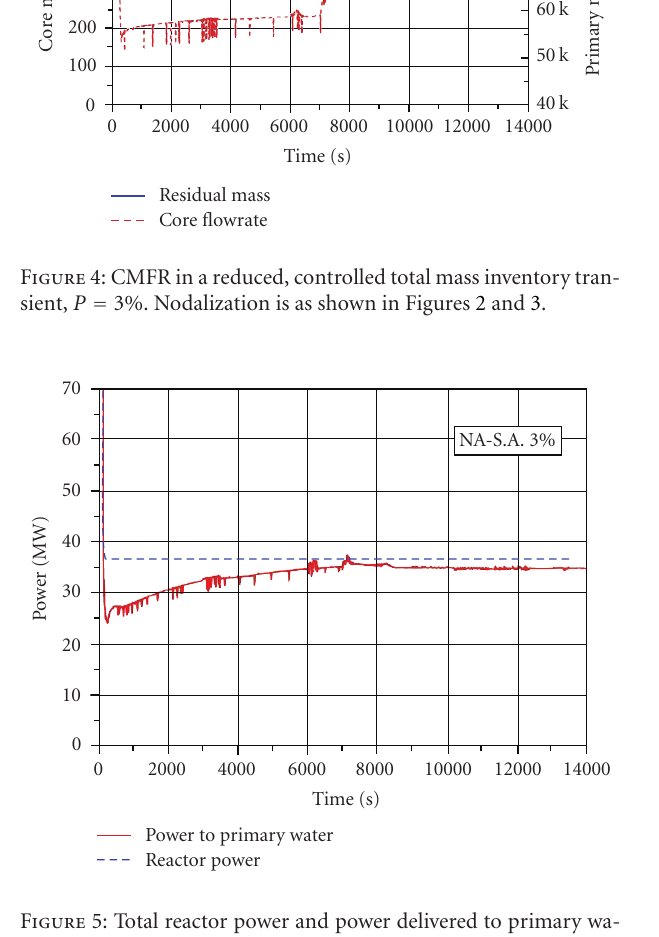
Figure 5: Total reactor power and power delivered to primary wa- ter.